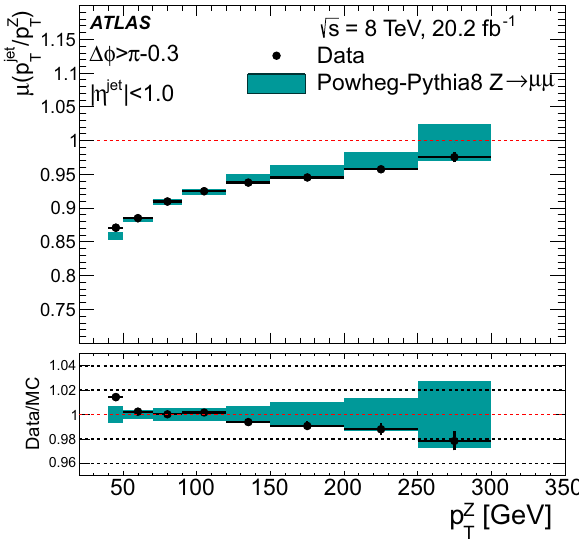
Fig. 25 Themeanvalueoftheratioofthetransversemomentumofajet to that of the reconstructed Z boson decaying to μμ . The uncertainties shown are